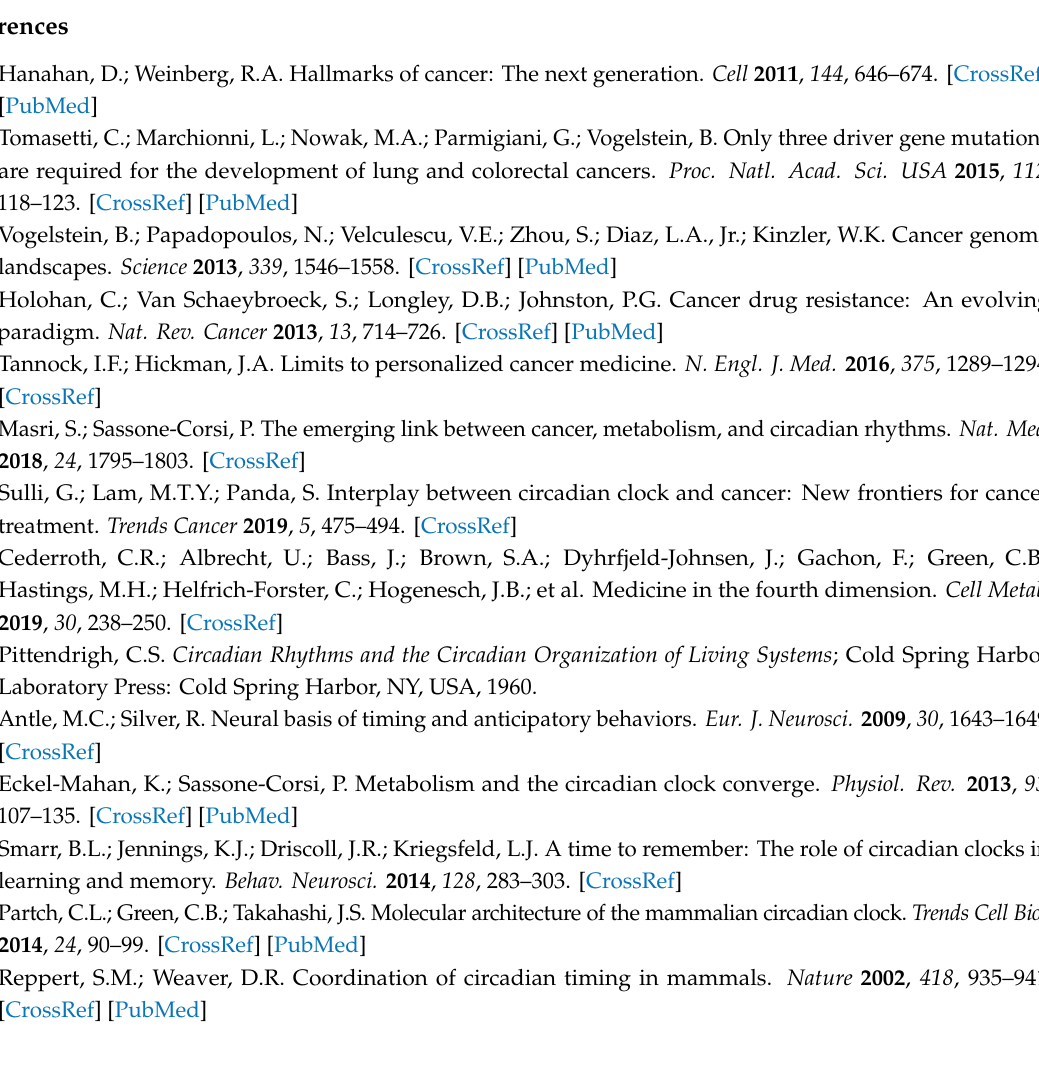
Table S4: The list of genes included in the Extended Core Clock Network, Table S5: Di ff erentially expressed genes (DEG) between tumor and adjacent normal tissue samples (FC > 1.5 and FDR <